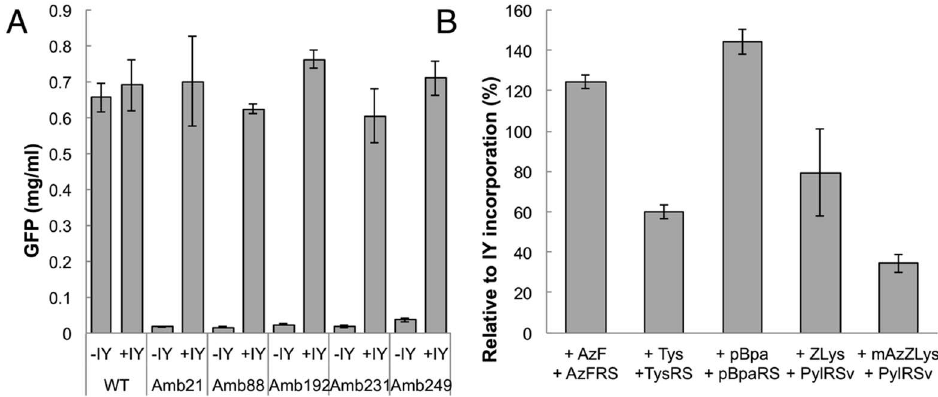
Figure 5. RFzero-iy-based cell-free system for non-natural amino acid incorporation. ( A ) The cell-free protein synthesis of wild-type N11-GFPS2 and UAG codon incorporated N11-GFPS2 mutants, with (+) or without ( − ) IY supplementation, were conducted with RFzero-iy-based S30 extracts. Wild-type GFPS2 is indicated as “WT”, and GFPS2 variants with UAG codons are indicated with the position numbers indicated after the prefix “Amb”. ( B ) The cell-free protein synthesis of N11-GFPS2(Y21amb) with supplementations of various non-natural amino acids and aaRS pairs, using RFzero-iy-based S30 extracts. PylRS(R61K–Y384F–Y306A) variant is indicated as PylRSv. Values are relative to the GFPS2 productivity of IY incorporation.